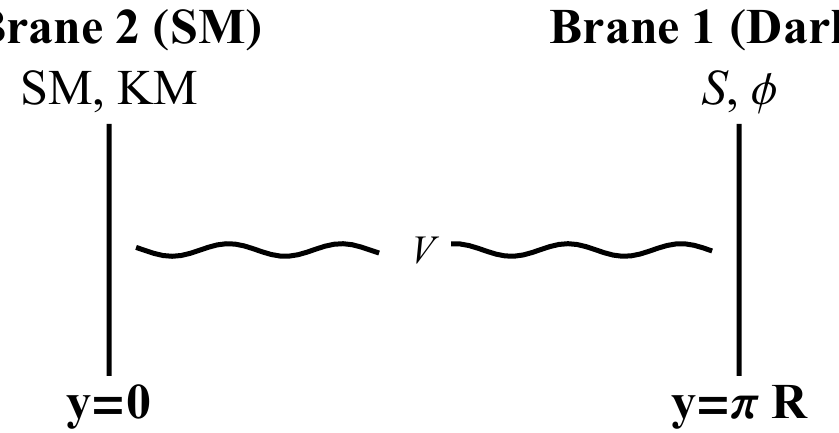
Figure 1 . A simple diagram overviewing the construction of our model. The fields φ and S , representing the complex scalar dark matter (DM) and the dark Higgs, respectively, are localized on Brane 1 (the “dark brane”) at y = πR . The Standard Model (SM) and kinetic mixing (KM) terms are localized on Brane 2 (the “SM brane”) at y = 0 . The bulk contains only one field, the dark photon V